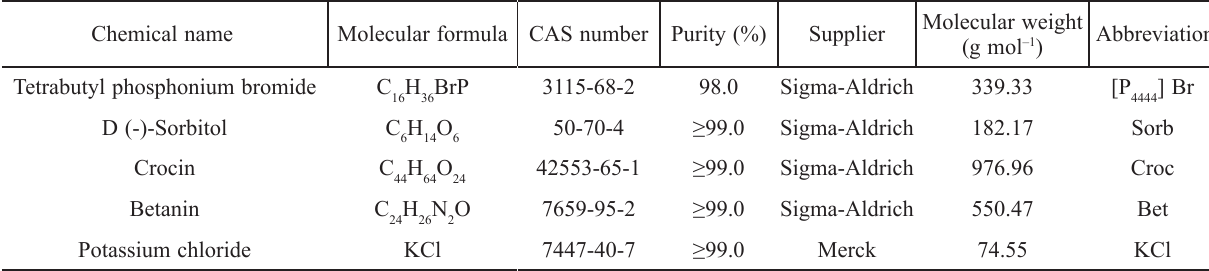
Table 1 – Materials used, suppliers, and general sample